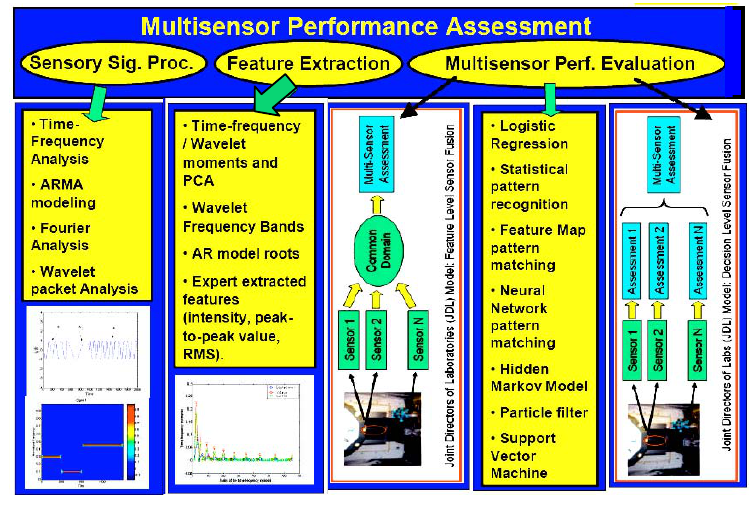
Figure 10. Multi sensor performance